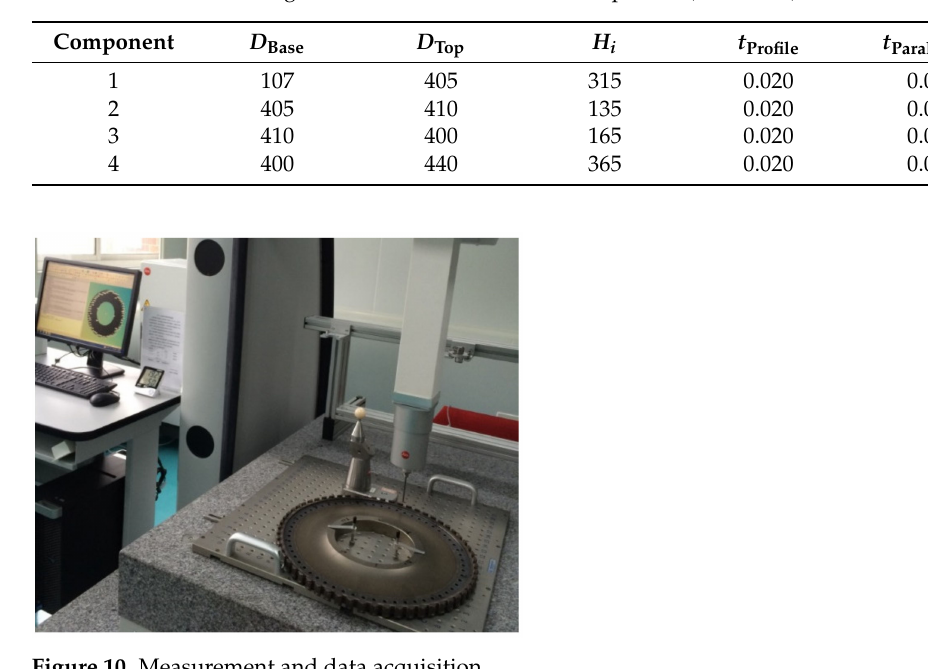
Table 3. Dimensions and geometric tolerances of each component (Unit: mm).